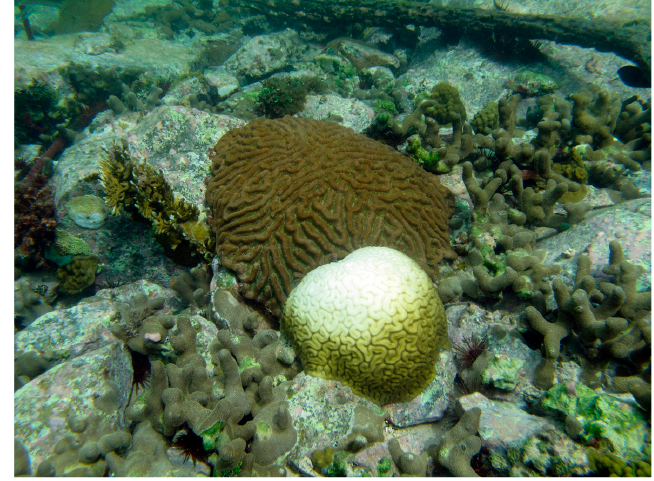
Figure 6. A bleached colony of Diploria labyrinthiformis next to an unbleached Colpophyllia natans.